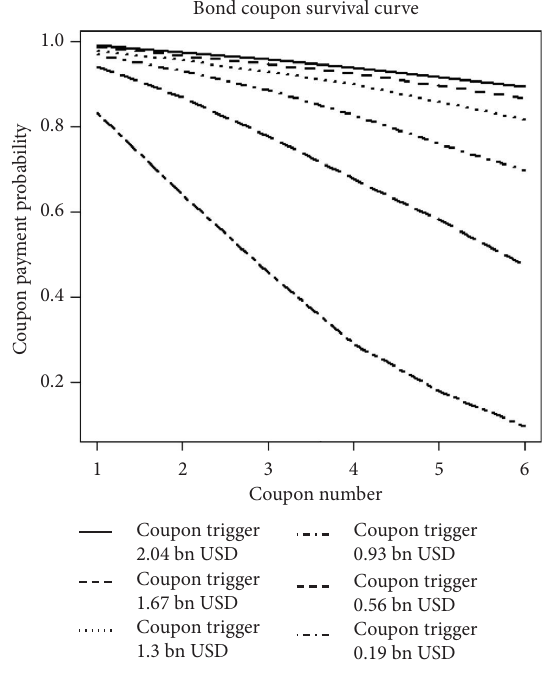
Figure 16: Cyber bond coupon survival curve for